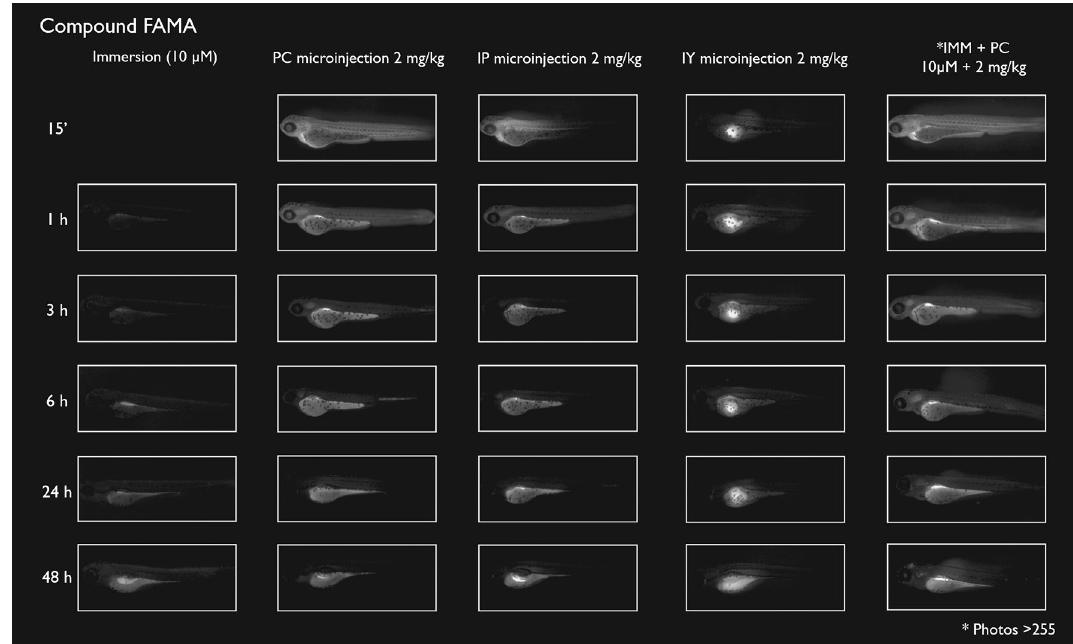
Figure 4. Representative pictures of the spatiotemporal distribution of the fluorescent compound FAMA. The eleuthero-embryos were exposed to the dye by immersion (10 µM) or microinjection (2 mg/kg) in the pericardial cavity (PC), intraperitoneally (IP) and in the yolk sac (IY), or by a combination of immersion and PC microinjection, for 48 h starting from 3 dpf. Selected images arranged in MS PowerPoint and GIMP (version 2.10.24 https:// www. gimp. org/ 2021) Software.